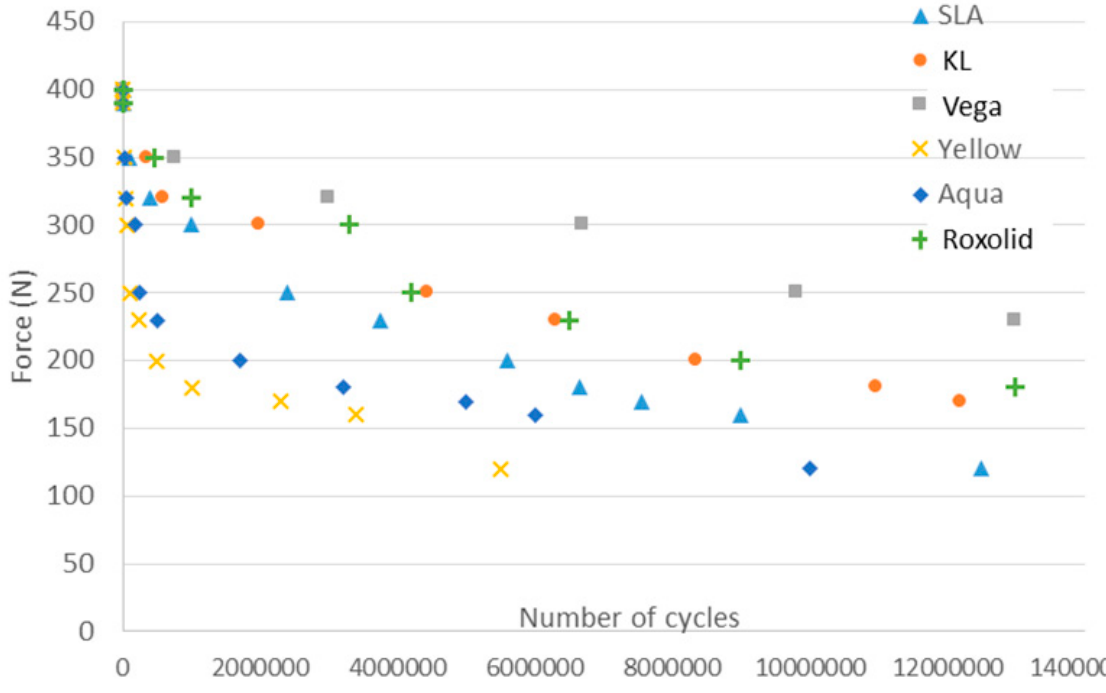
Figure 3. Stress–number of cycles to fracture (S–N) curve of the different narrow dental implants.